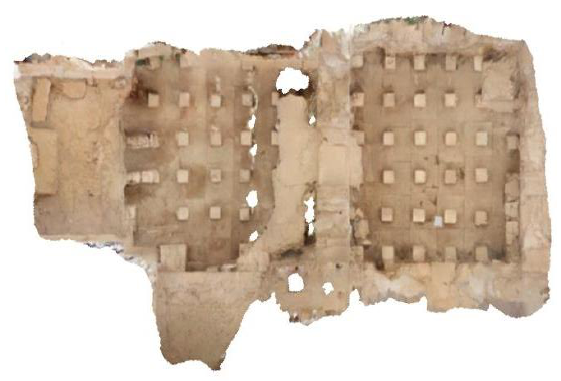
Figure 5. Orthophoto of the caldarium (on the left) and of the sudatorium (on the